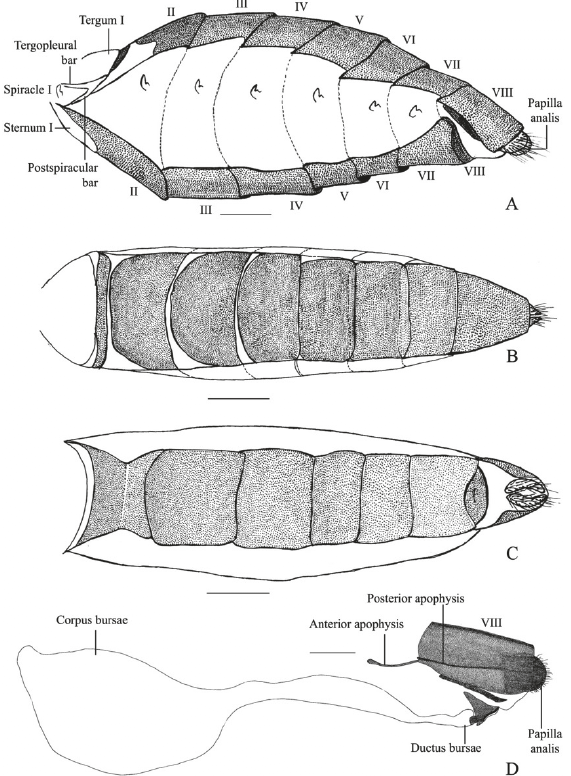
Figure 6. Female genitalia of Junonia iphita (Cramer, 1779) A – C - abdomen (lateral, dorsal and ventral view); D - female genitalia (lateral view). Scale bar